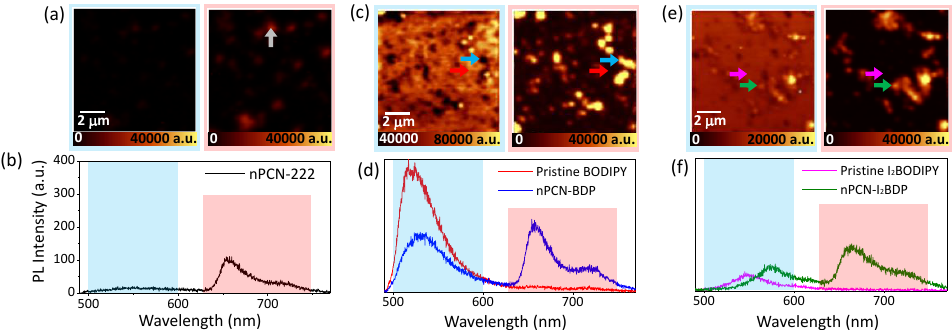
Figure 4. Fluorescence maps and representative local fluorescence spectra of ( a,b ) nPCN-222, ( c,d ) nPCN-BDP, and ( e,f ) nPCN-I 2 BDP samples. The fluorescence maps were obtained by integrating the donor (BODIPY / I 2 BODIPY) emission range of 500–600 nm (blue box) and acceptor (nPCN-222) emission range of 630–750 nm (red box). In each map, local representative fluorescence spectra were obtained from the location marked by the